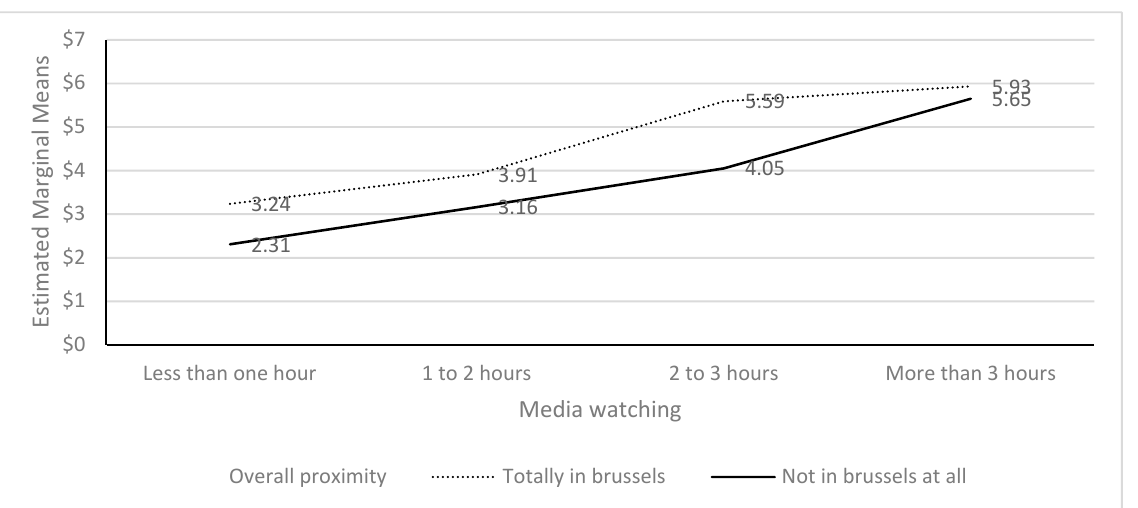
Figure 1. PHQ-4 as an outcome of the interaction between media watching and work proximity. Overall, proximity had a significant interaction with media watching for mental symptoms (F = 3.145; p = 0.024). While the lines did not intersect, the means for more than 3 h of media watching and proximity with regard to mental symptoms are almost the same, indicating that the difference between living and working in Brussels was not different in terms of mental symptoms compared to watching more than three hours of media on the attacks. The variables media watching ( p < 0.001) and proximity ( p < 0.001) were both significant predictors in the analyses (see Figure 2).